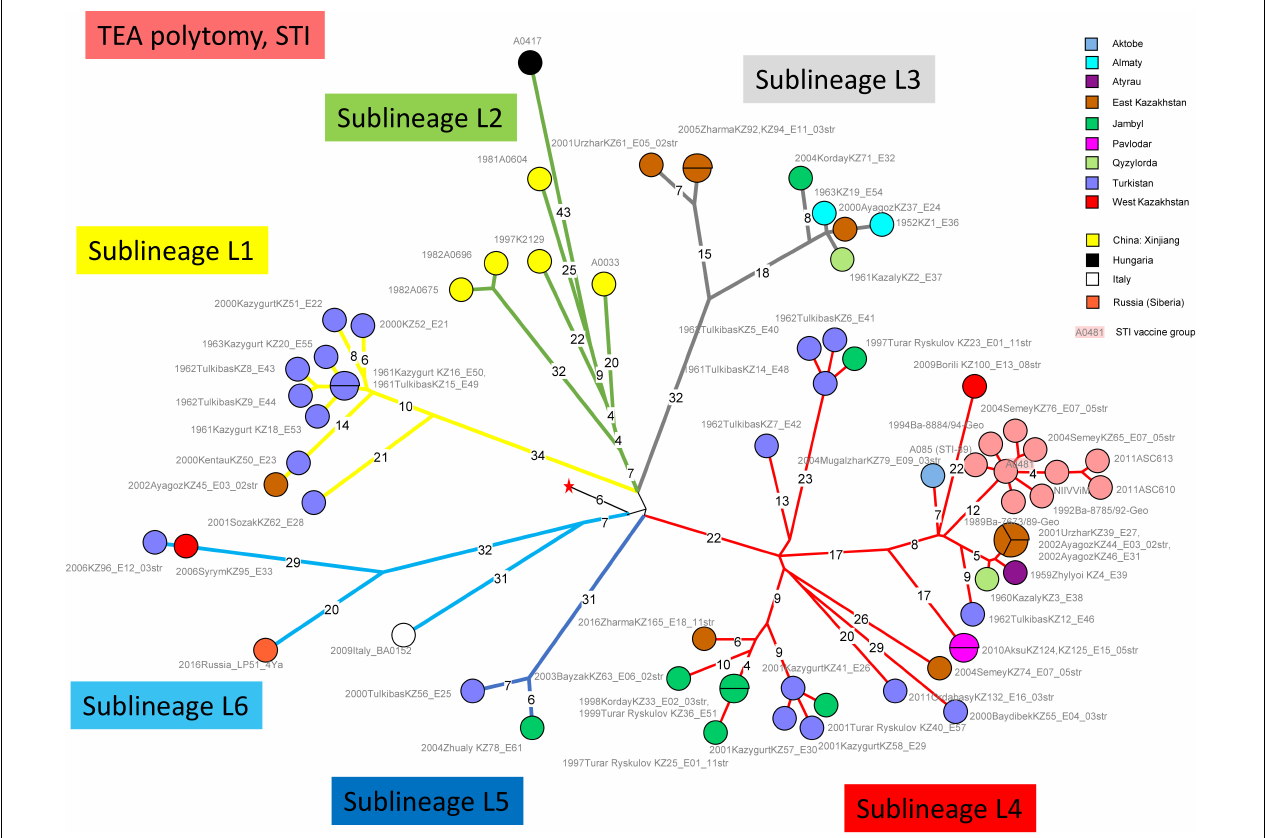
FIGURE 1 | Whole Genome Single Nucleotide Polymorphism (wgSNP) analysis of strains assigned to TEA clade “Sanitary Technical Institute (STI).” Maximum parsimony analysis. 859 SNPs in tree, tree size 867 (homoplasia 0.9%). Branch lengths of four SNPs and more are indicated, a linear scale was used. The red star indicates the position of the root (MRCA) of the TEA polytomy. Each strain is labeled with year of isolation, place (district level or country), strain Id, event number, number of associated strains when above one. Color code reflects the geographic origin of the strains. The STI vaccine strain A0481 is shadowed in pink. Six deep-branching sublineages are defined and branches are colored